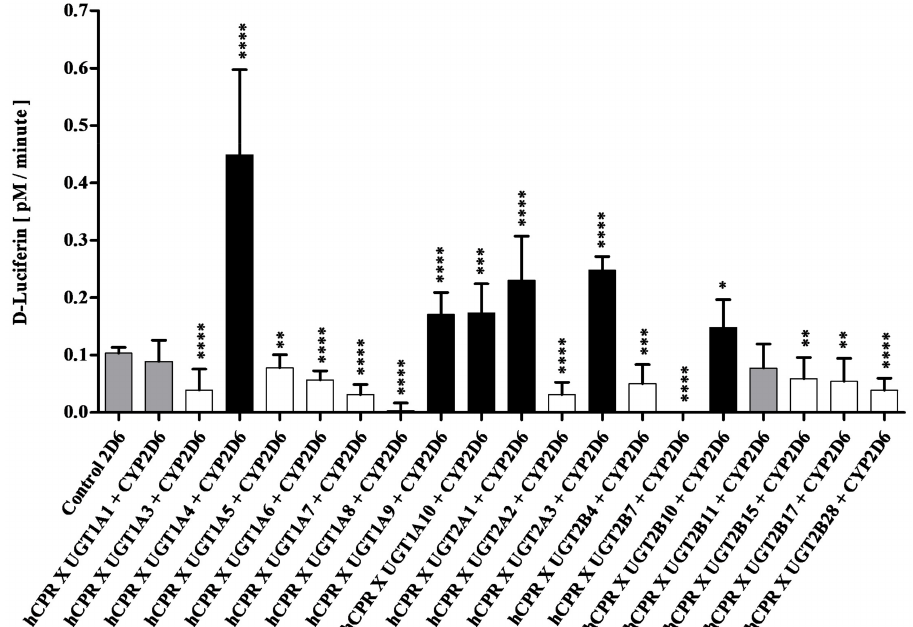
Figure 3. Enzymatic activities of enzyme bags prepared from diploid strains co-expressing CYP2D6, CPR, and different UGTs as indicated. Activities towards the substrate Luciferin-MEEGE are shown in comparison to the control strain SAN300 (which co-expresses CYP2D6 and CPR without a UGT). Activities that are not different from the control are shown in grey, while those that are statistically significantly higher or lower than the control are shown in black or white, respectively. * p < 0.05,